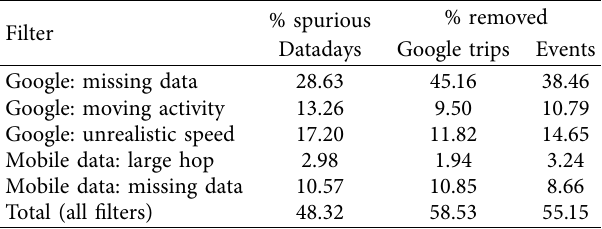
Table 3: Result of the data filtering of the validation dataset. If a day for a certain user (dataday) contains spurious data, both the Google trips and cellular events on that day are removed from the data.